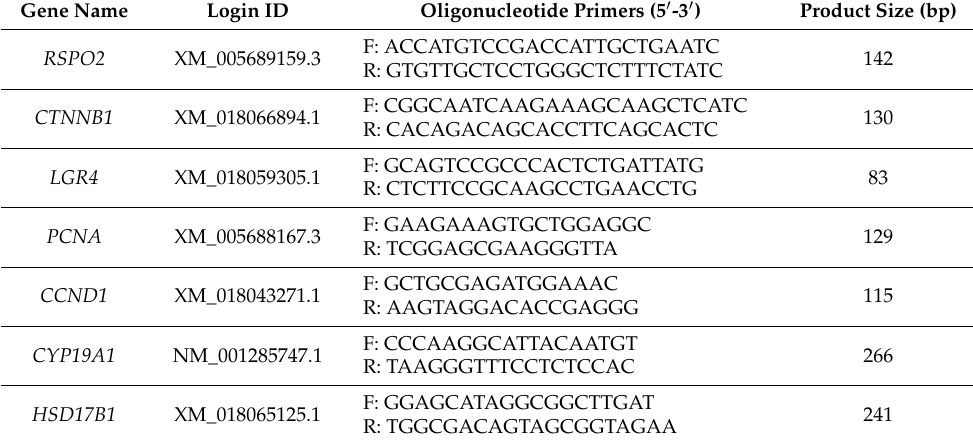
Table 2. The primers for qRT-PCR of related genes.